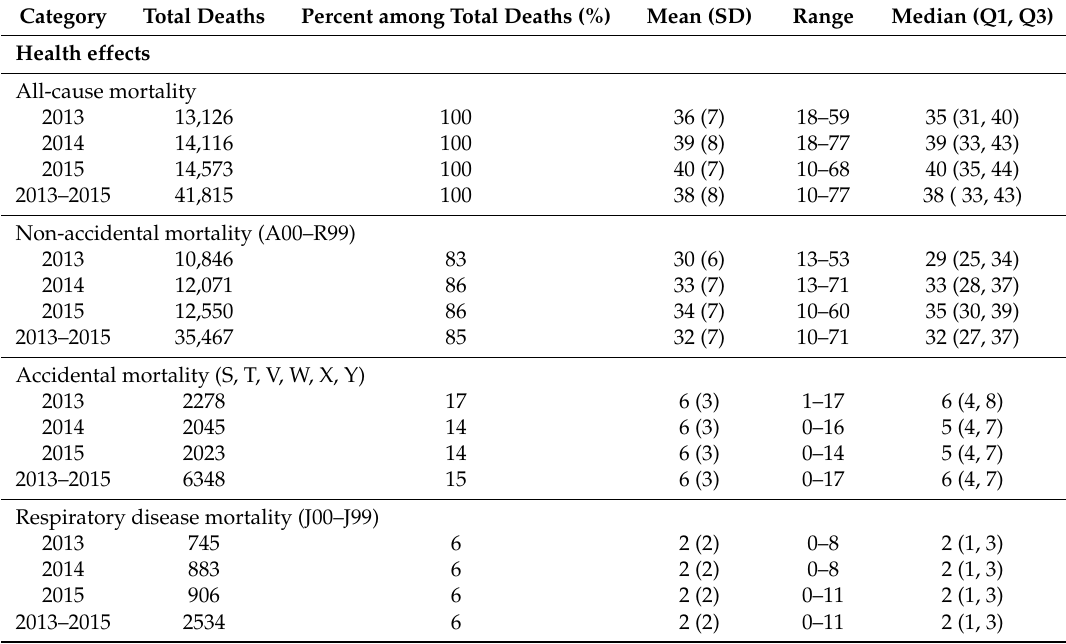
Table 1. Basic information of mortality residents in Shenzhen